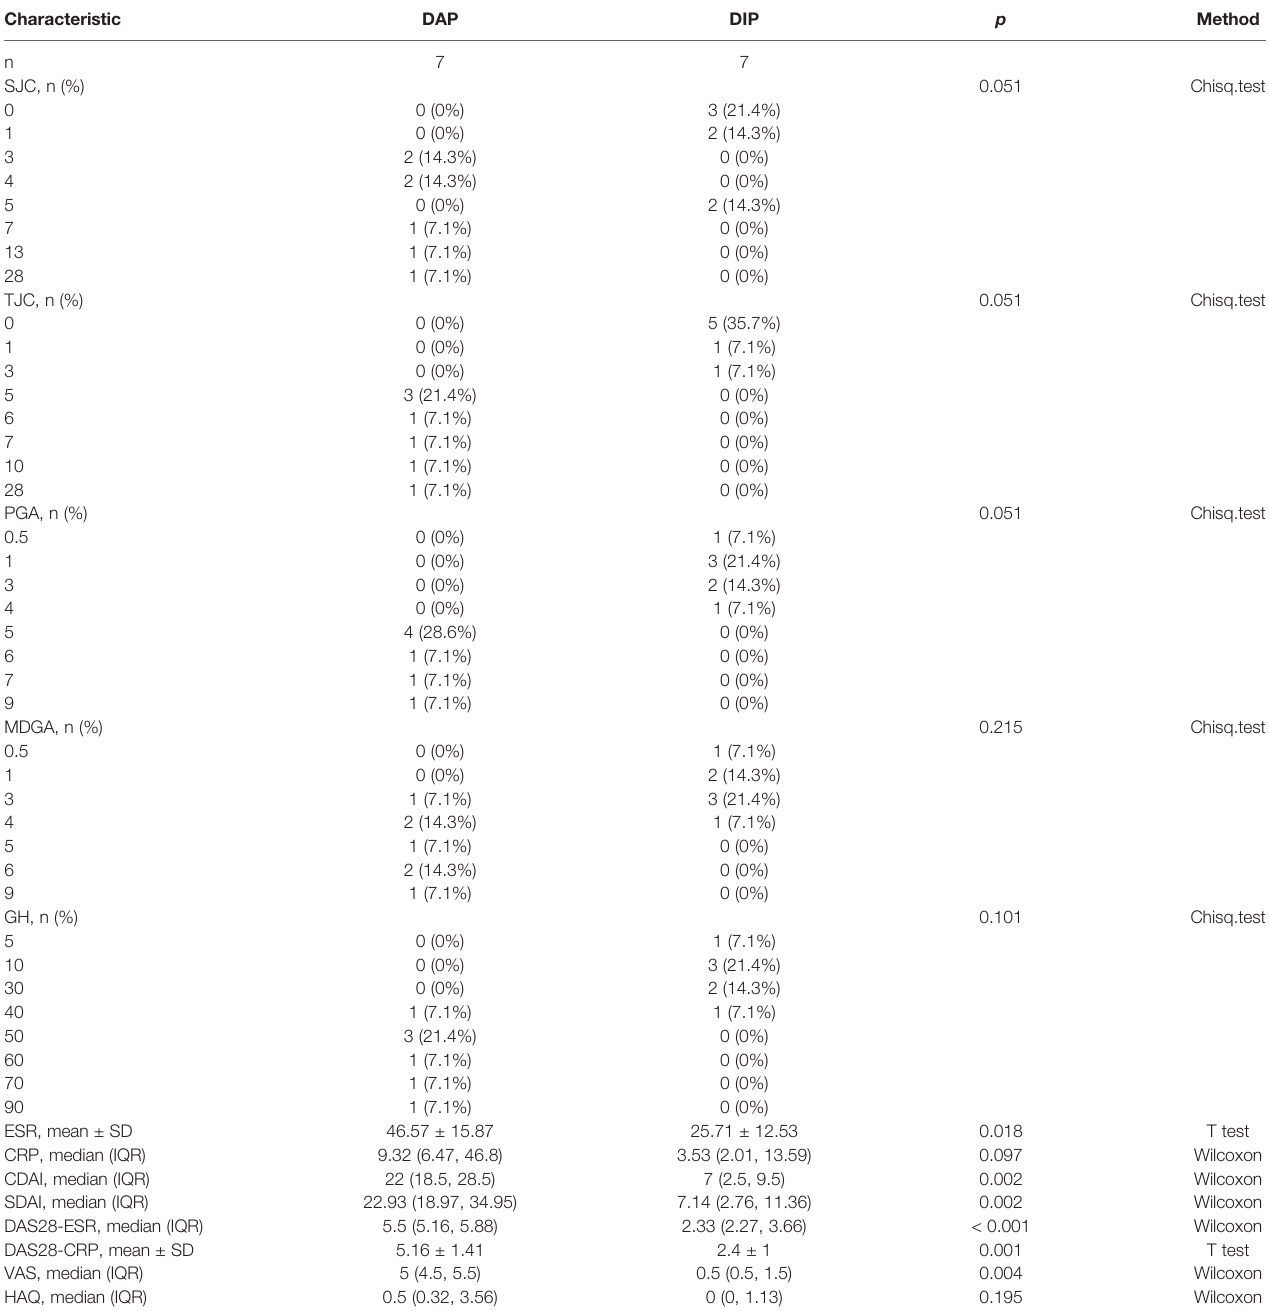
TABLE 2 | Clinical indicator information.